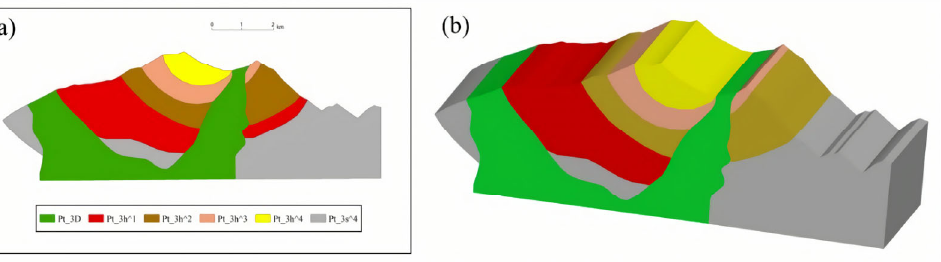
Figure 20. Fold structure modeling based on measured cross-section: ( a ) section of the Danaobo mountain syncline at Hanyang Peak of Mount Lu and ( b ) symbol model of the Danaobo mountain syncline. A box fold refers to a fold in which the strata are all overturned, and the hinge